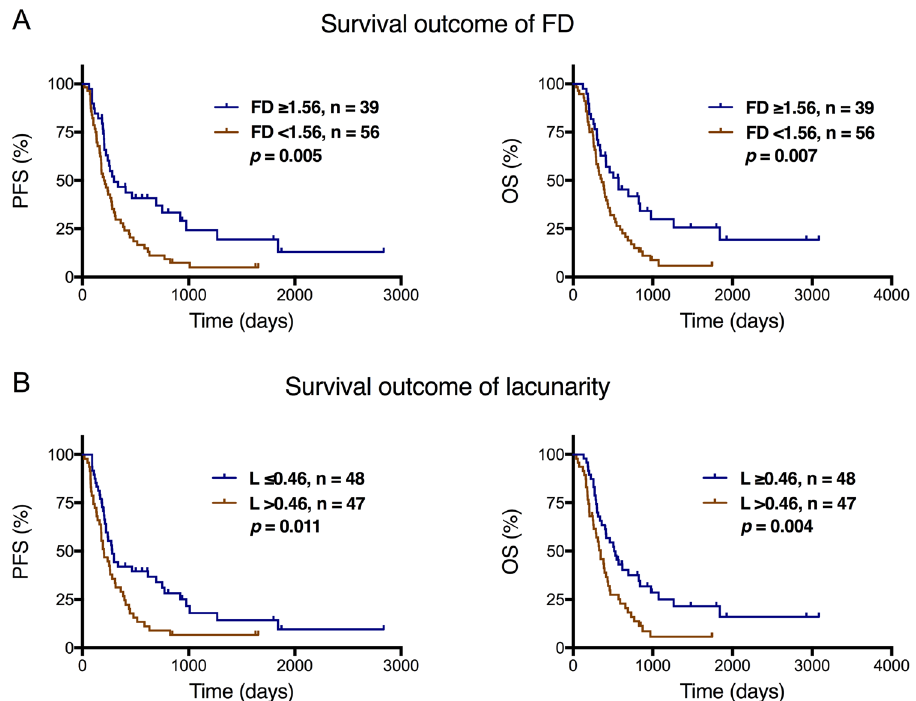
Figure 2. Kaplan-Meier curves showing the association of progression-free survival (PFS) and overall survival (OS) with the ( A ) fractal dimension (FD) and ( B ) lacunarity